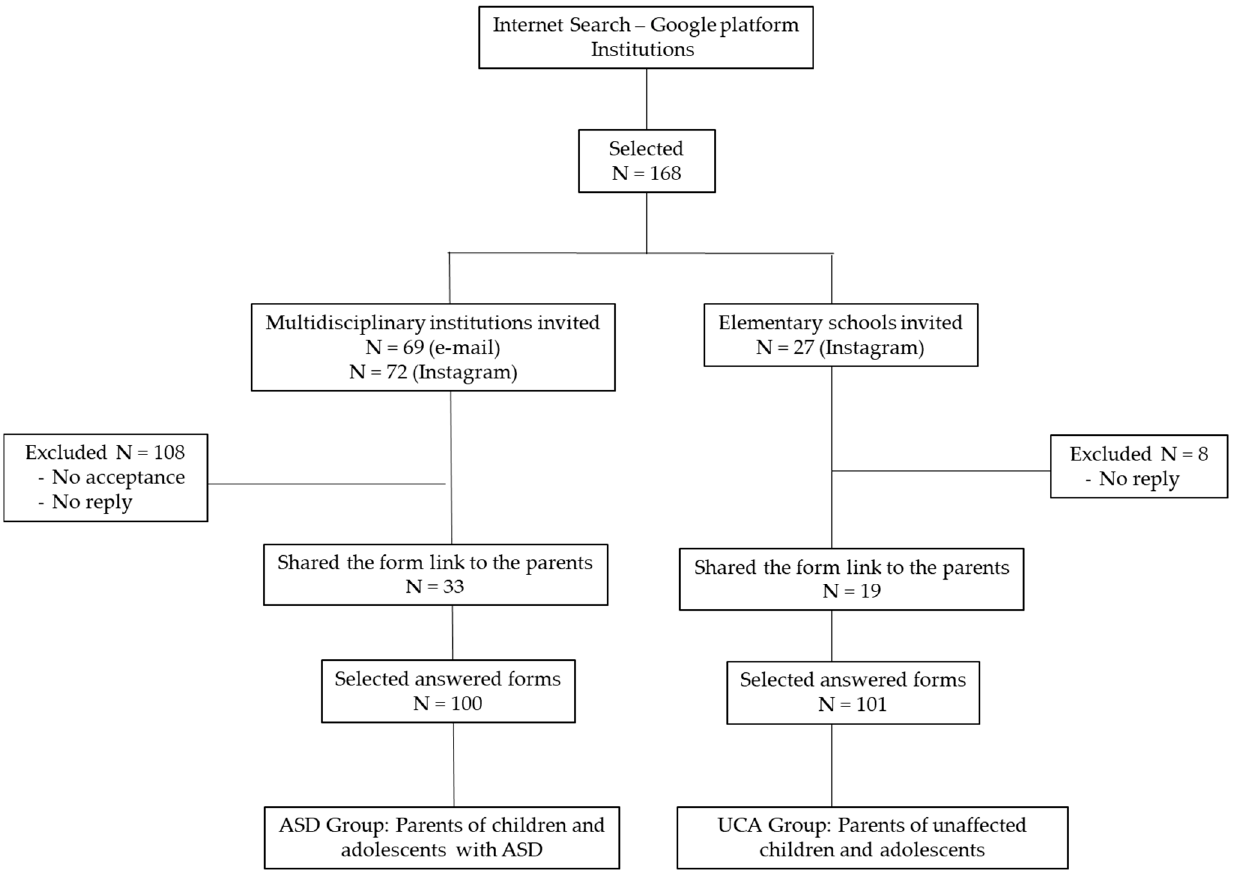
Figure 1. Flowchart referring to the invitation and acceptance of institutions to obtain the